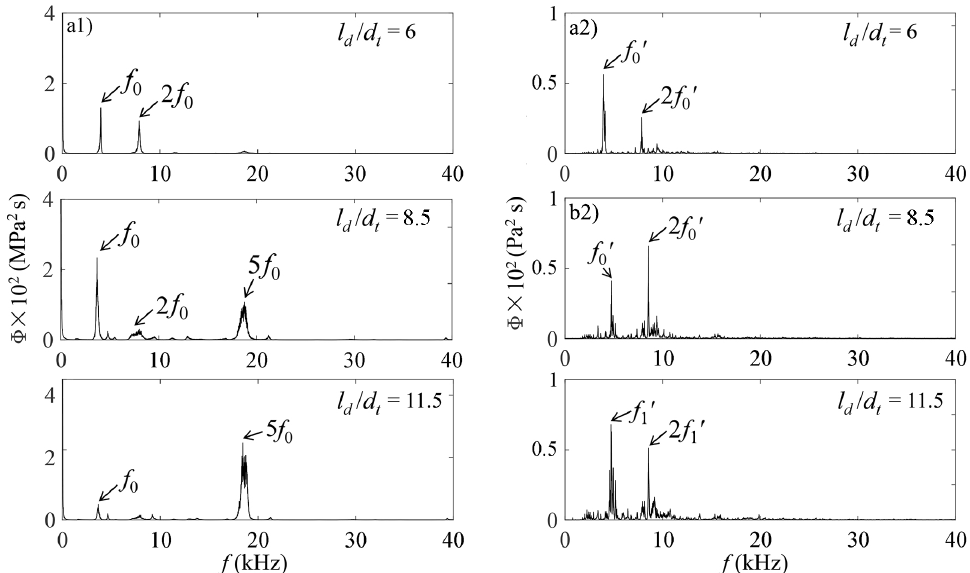
Figure 14. Spectra of the self-resonating oscillations (left column) and the cavitation noise (right column) at α = 30 ◦ . ( a1 , a2 ) l d / d t = 6; ( b1 , b2 ) l d / d t = 8.5; ( c1 , c2 ) l d / d t =